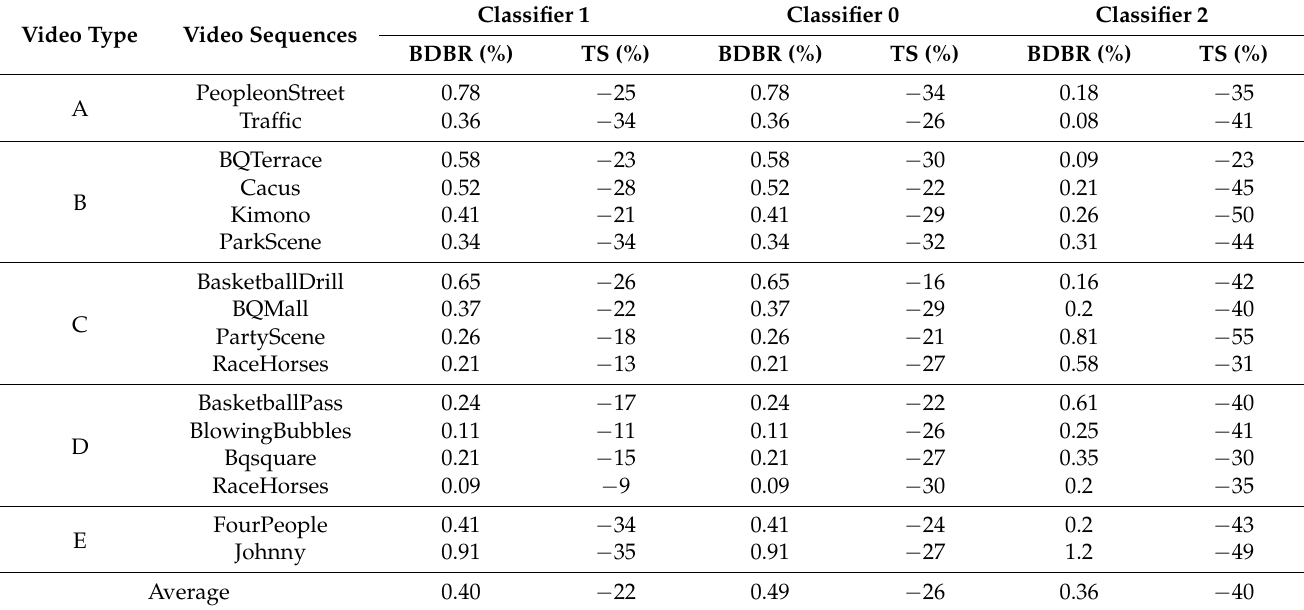
Table 5. Results of two individual schemes compared to HM16.5